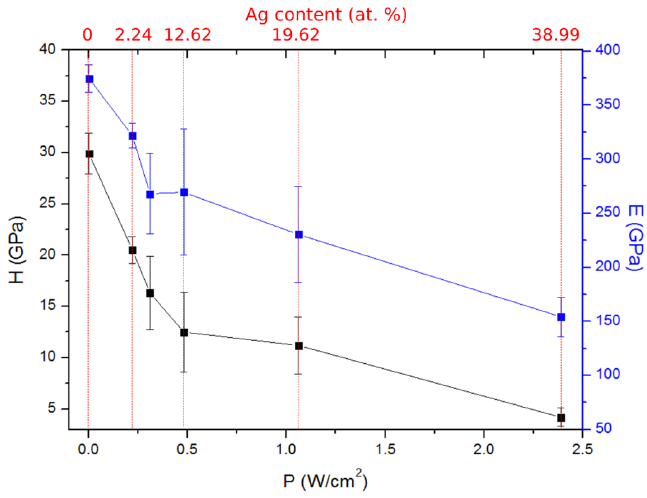
Figure 4. Experimental hardness (H) and Young’s moduli (E) of the reference ZrB 2+ Δ and Zr 1 − x Ag x B 2+ Δ fi lms plo tt ed as a function of the power density on Ag target and Ag content.